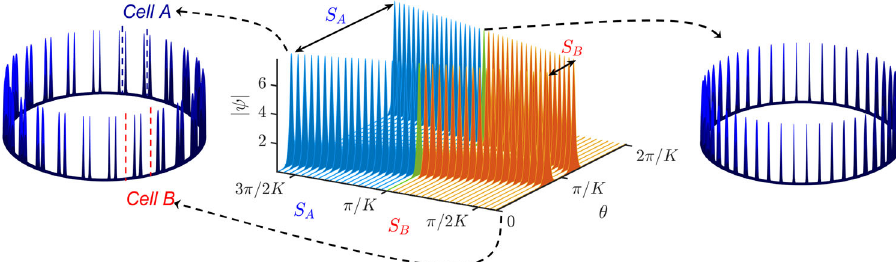
Fig. 1 Soliton metacrystals and dimerization choices. The middle panel shows how two solitons are positioned in the unit cell for varying separation distance, S α . Two side panels show all 2 K = 48 solitons along the ring circumference. The right plot corresponds to S A = S B , i.e., when the molecular crystal degenerates to the atomic one. The left plot shows the molecular metacrystal and illustrates the two dimerization choices applied in this work, S + S = 2 π / K . The scaled dispersion and detuning parameters are d A B S α , but d κ remains close to − 0.01059. The dimensionless fi eld amplitude, ψ , is expressed as γ ∣ ϕ ∣ 2 / κ = ∣ ψ ∣ 2 . The dimensionless pump parameter is γ h 2 / 1 / κ = 25. Crystals are computed with 512 points across the unit cell, θ ∈ [0, 2 π / K